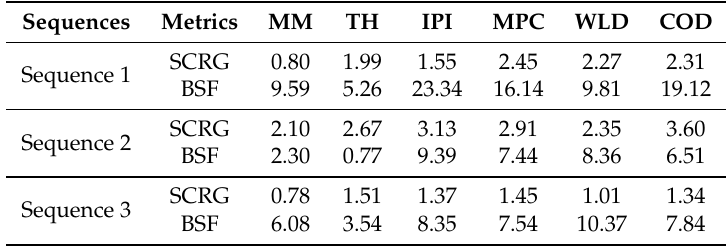
Table 5. Average scores of the proposed method and other existing